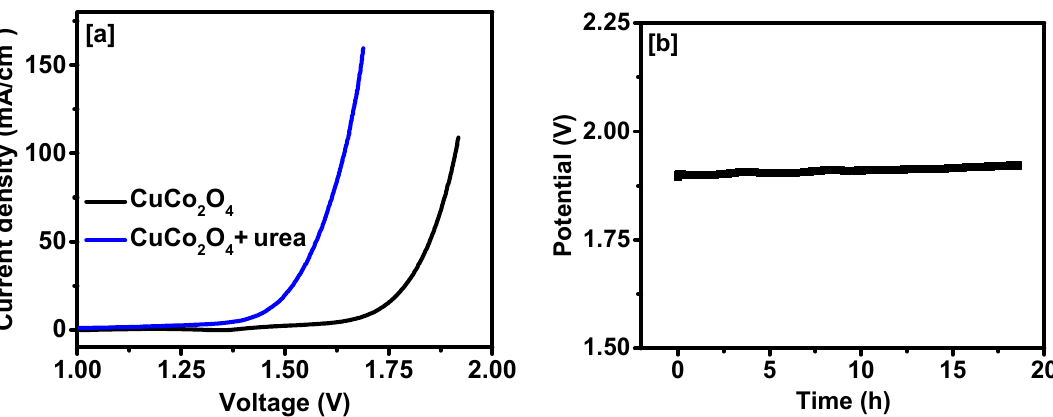
Figure 7. ( a ) Polarization curves for the CuCo 2 O 4 electrode in 1 M KOH without and with 0.33 M urea, and ( b ) chronopotentiometric curve for the CuCo 2 O 4 electrode.